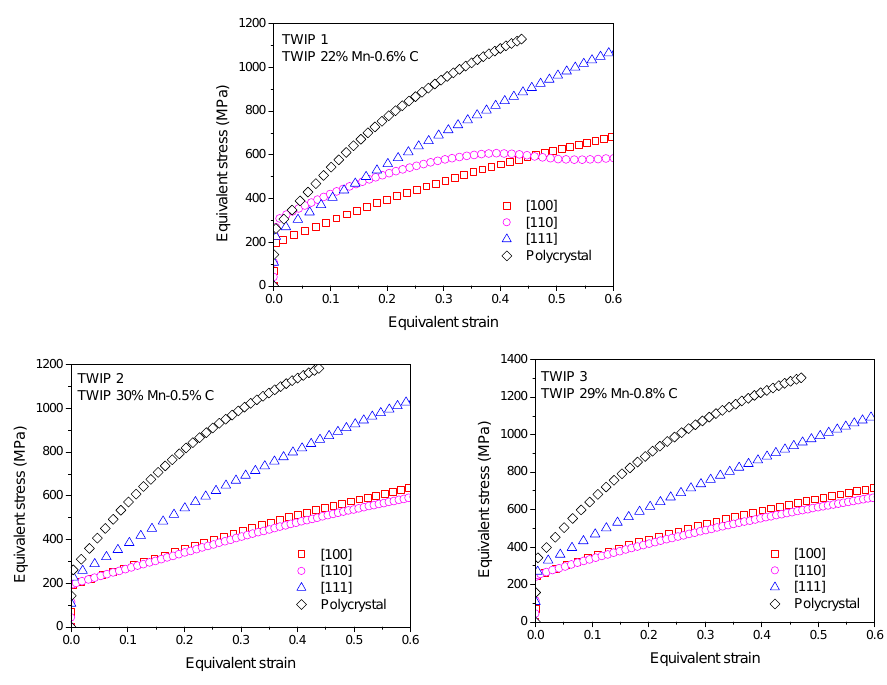
Figure 8. Deformation behavior of single-crystal and polycrystal TWIP steels subjected to